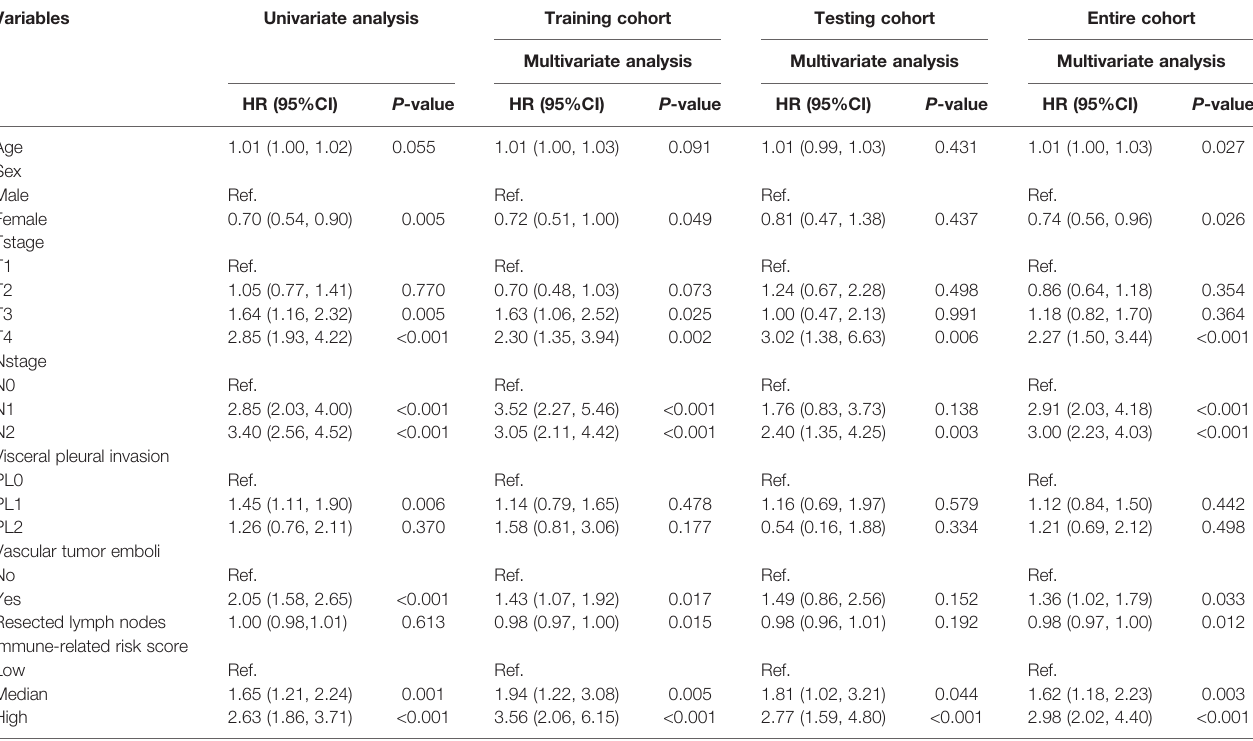
TABLE 1 | Construction and validation of immune-related risk score for predicting the disease-free survival of non-small cell lung cancer. Variables Univariate